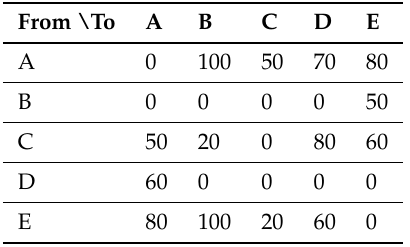
Table 2. Simple example origin destination matrix